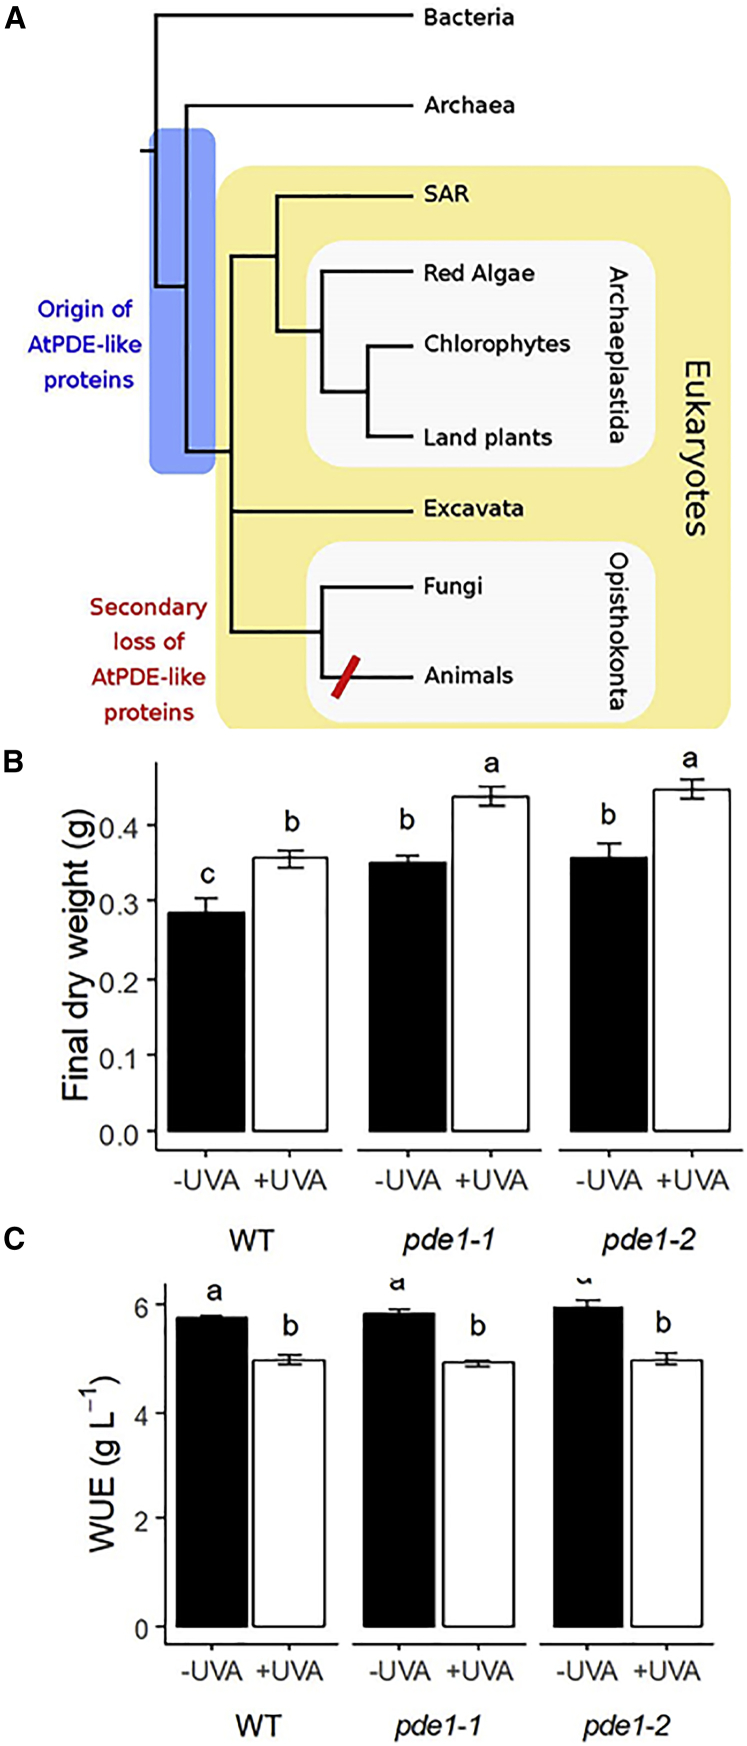
Evolution of AtPDE-Like Proteins and Effect of UVA on Growth and WUE(A) Cartoon species tree of the major groups of life highlighting the origin and later secondary loss of AtPDE-like proteins. Based on the widespread presence of AtPDE-like proteins in bacteria, archaea, and eukaryotes, we predict an origin of AtPDE-like proteins prior to the last eukaryotic common ancestor highlighted with blue box. AtPDE-like proteins were then conserved in the major groups of eukaryotes before being secondarily lost in the animal stem lineage prior to the diversification of the modern animal groups.(B and C) Long-term UVA exposure enhances growth and does not affect water-use efficiency. Arabidopsis plants were grown under light tubes supplemented with a combination of blue (λmax = 470 nm) and red (λmax = 660 nm) light coupled or not to UVA light (λmax = 370 nm) (as in Figure 1). All conditions other than presence or absence of UVA were identical (PAR = 120μmol m−2 s−1, temperature 22/20°C [day/night], relative humidity 70%, 12 h photoperiod). Final plant dry weight was measured at bolting (B). Individual pots were sealed to stop water evaporation from the soil, and each pot was weighed daily from germination until bolting to compute cumulated plant water loss through transpiration. Whole plant water-use efficiency (WUE) was calculated as the ratio between final dry weight and cumulated water loss (C). Data represent means (+/− SE) of 8 plants per genotype and light scenario. Statistical analyses were performed by one-way ANOVA with Tukey post hoc analysis, and letters show significant differences at p < 0.05.See also Figure S2 and Data S1 for more information. See also Figure S4.